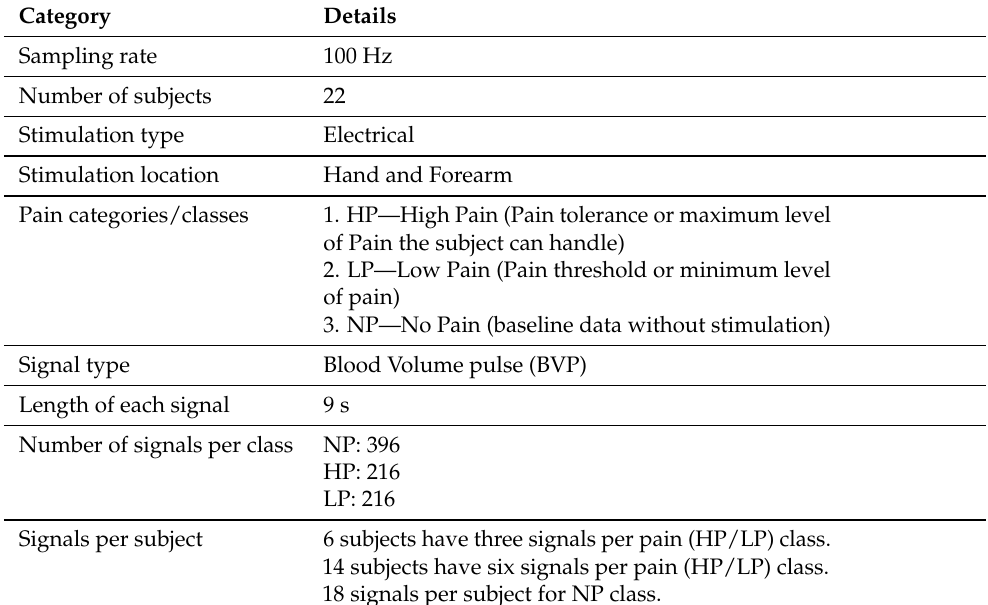
Table 1. Summary of the dataset used for the detection and classification of pain.